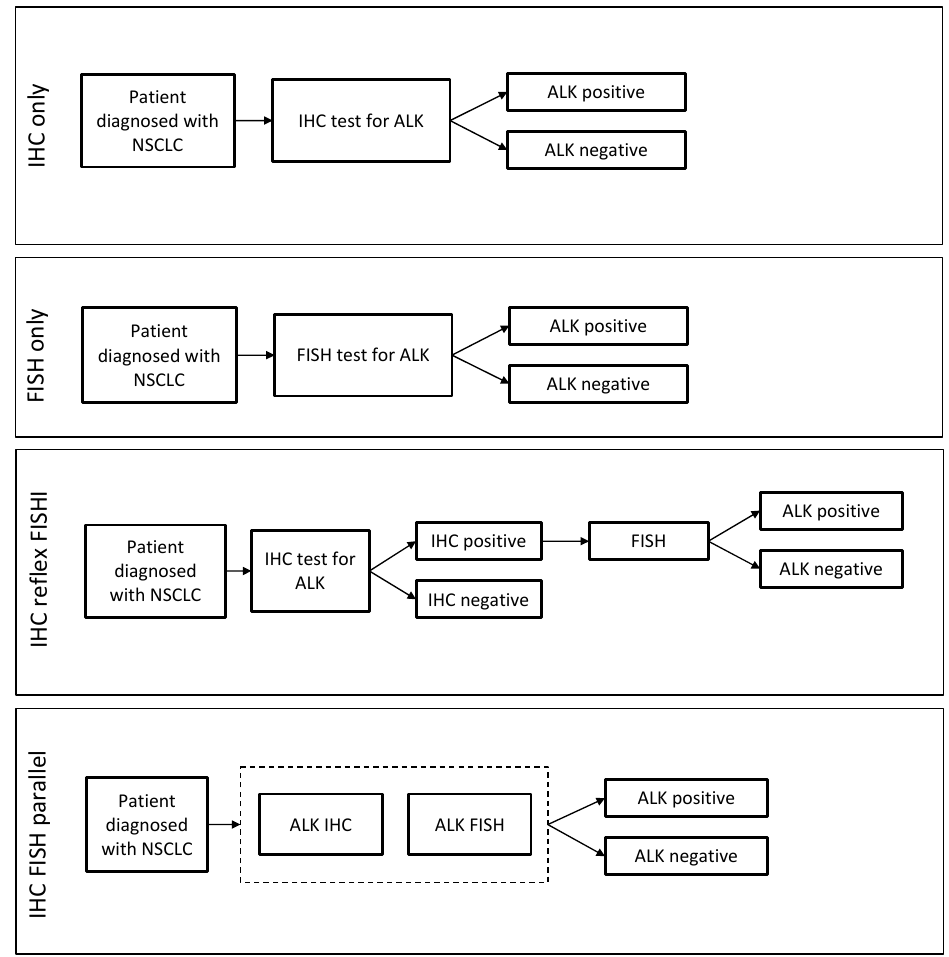
Figure 1. Alternative testing strategies employed by laboratories included in the research for ALK rearrangement detection in non small cell lung cancer (NSCLC) patients. The strategies comprise of fluorescent in situ hybridization (FISH) and immunohistochemistry (IHC) individually or in combination. In the “IHC reflex FISH” testing strategy, only patients that test positive via IHC and FISH are considered positive for ALK rearrangement and would be eligible for TKI treatment in the model. In “IHC FISH parallel” strategy, the dash line box indicates use of both IHC and FISH in parallel, and in no particular order, to determine ALK status.